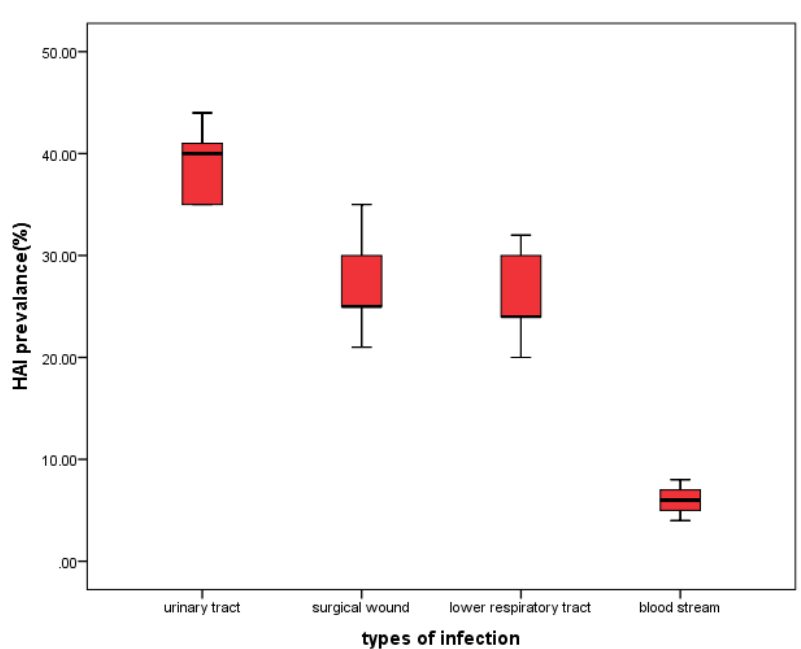
Figure 1. Box plot graph depicting hospital-acquired infection